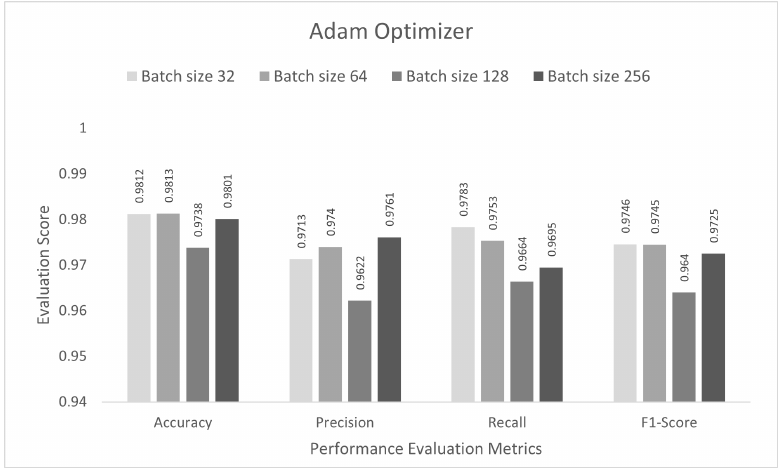
Figure 6. Adam optimizer for multi-class category classification scenario.